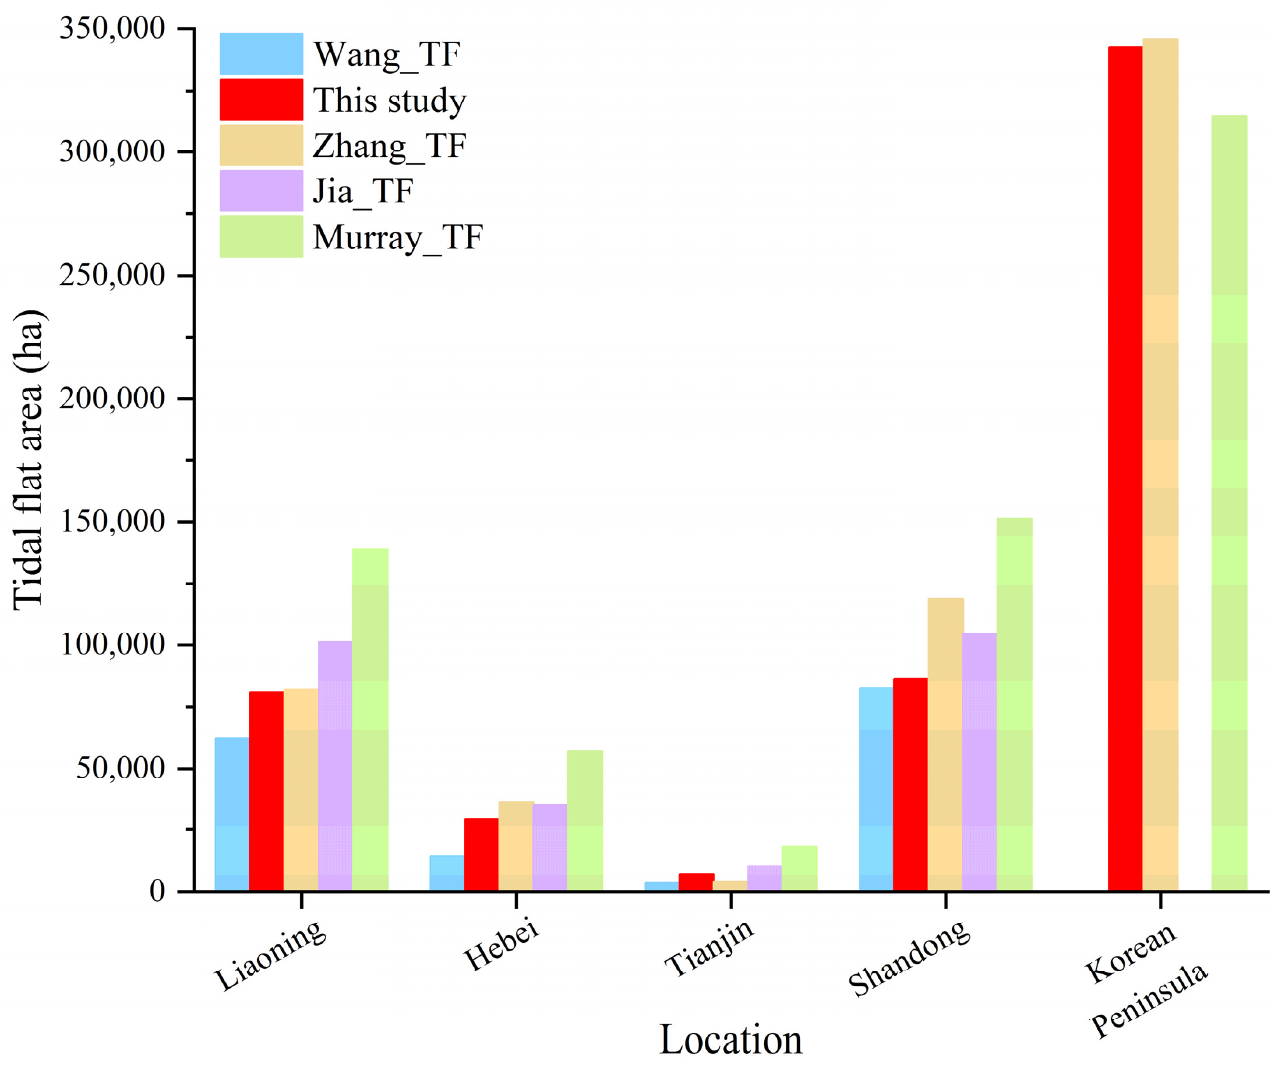
Figure 7. Comparisons of tidal flat areas between our result (“This study”) and other results, including newest Murray_TF [1], Wang_TF [26], Jia_TF [4], and Zhang_TF [10].